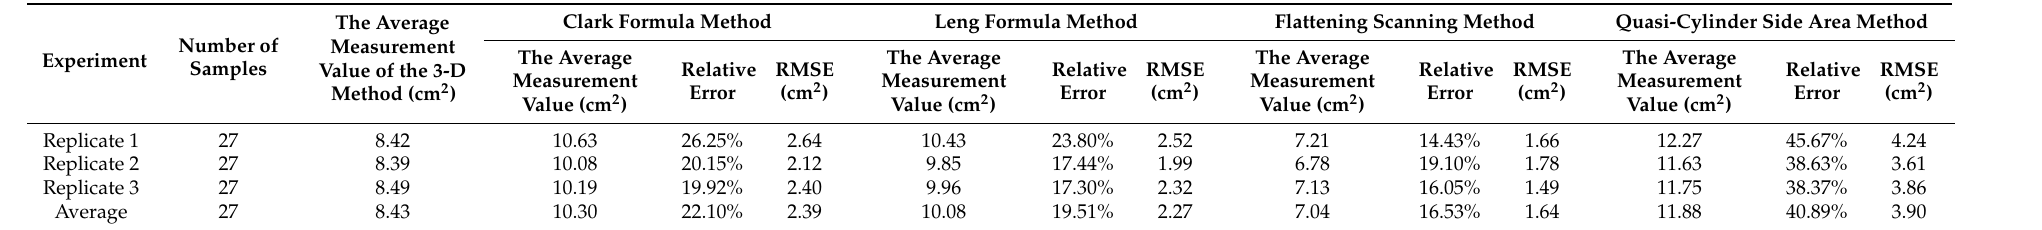
Table 2. Analysis of the accuracy of the measurement results using the other four